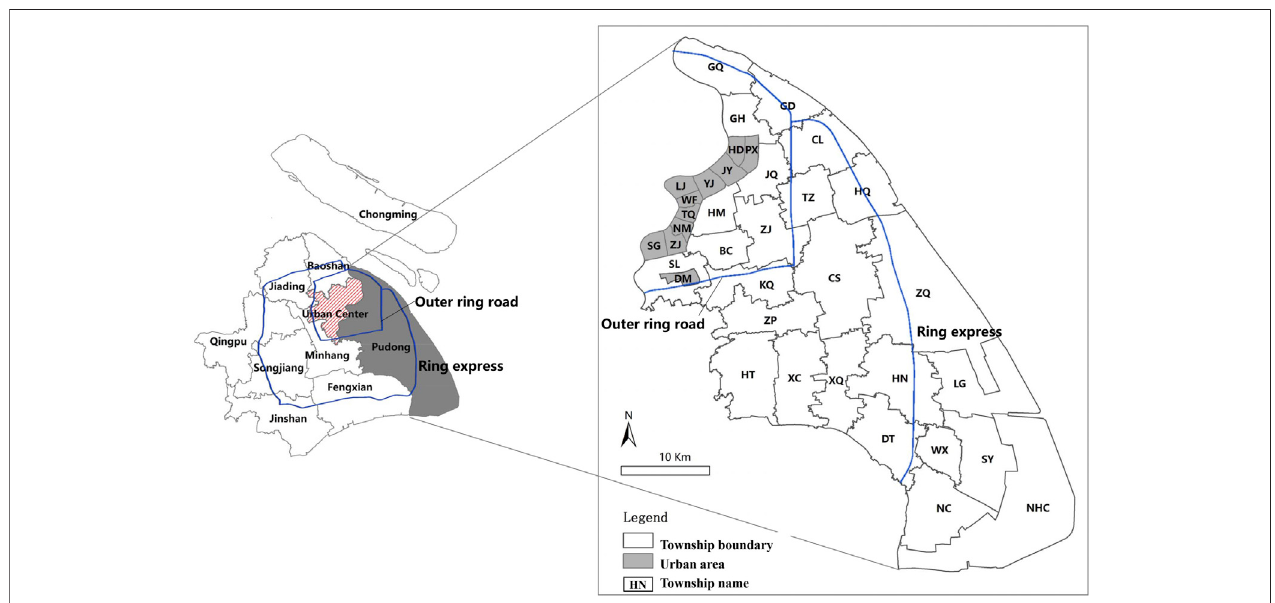
FIGURE 1 | Location and township boundary in